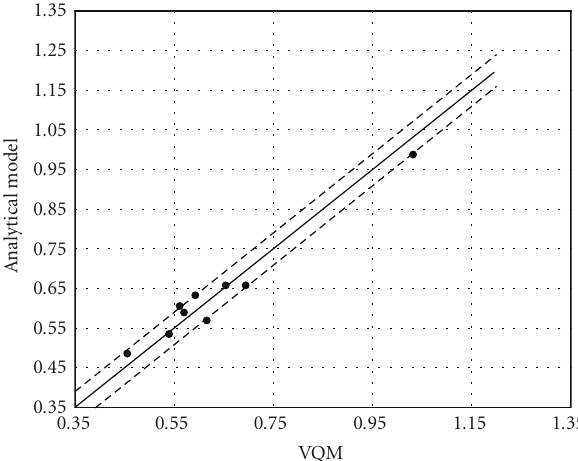
Figure 9: VQM quality versus analytical model quality, signal power level − 15 dBm.